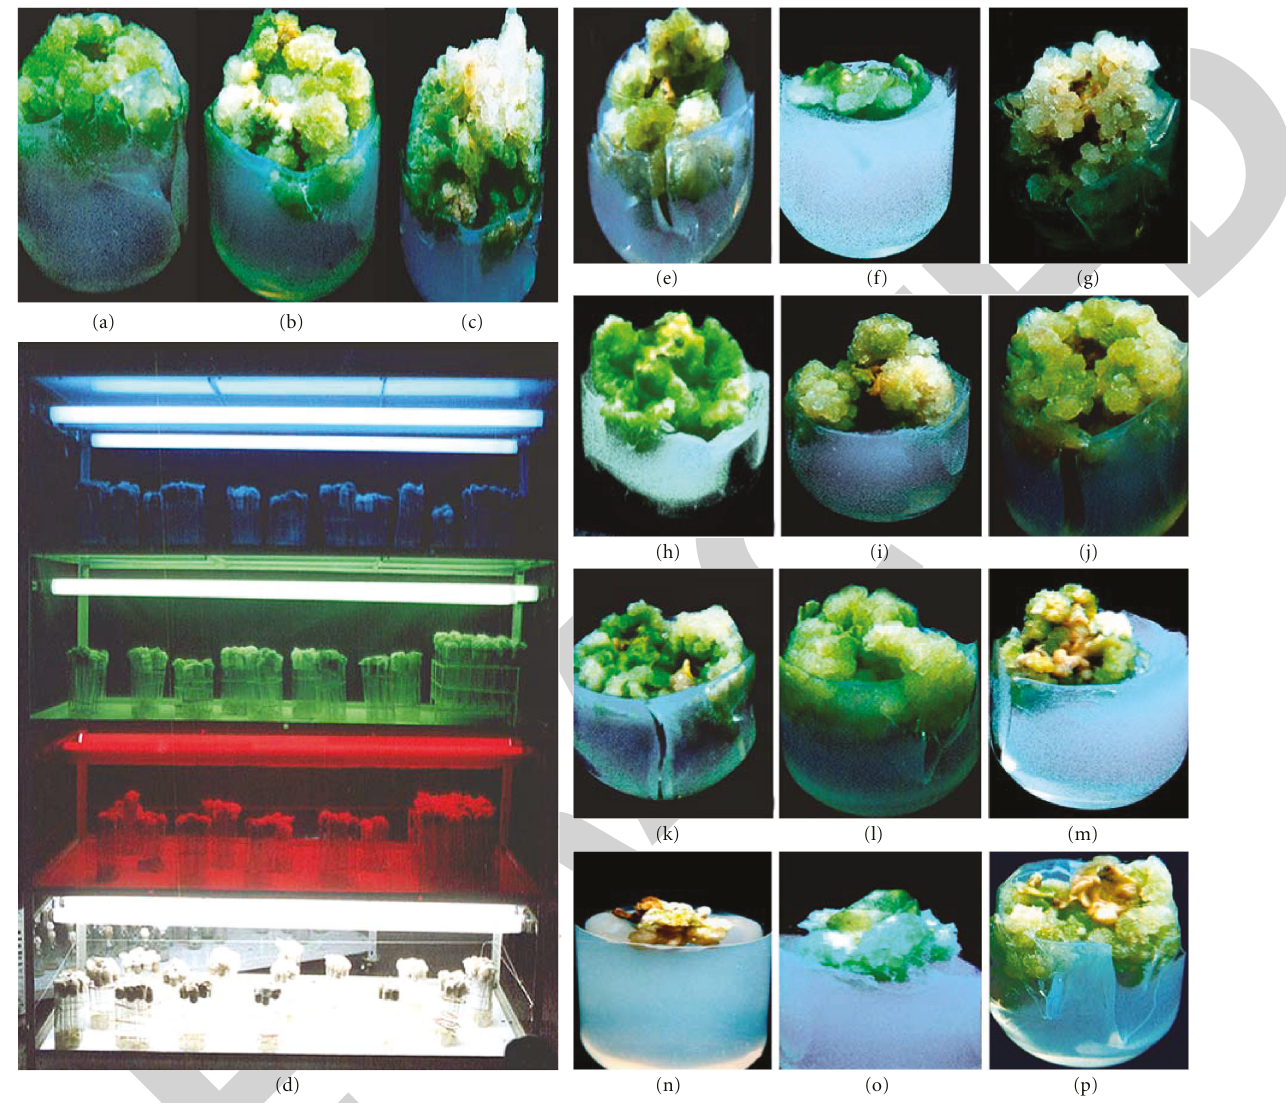
Figure 4: MS medium supplemented with OPGRs, physical and chemical treatments on leaf explants of Gymnema sylvestre induced callus after 45 days incubation. (a) Blue light (1.8x); (b) red light (1.8x); (c) green light (1.6x); (d) color light setup; (e) 30 ◦ C (1.7x); (f) 20 ◦ C (1.8x); (g) 35 ◦ C (1.6x); (h) 5% (1.2x); (i) 2% (1.4x); (j) 4% (1.4x); (k) 6% (1.2x); (l) 12h/12h (light/dark, 1.9x); (m) 4 h/20h (light/dark, 1.7x); (n) 24h light (1.5x); (o) 24h dark (1.8x); (p) 8h/16 h (light/dark,